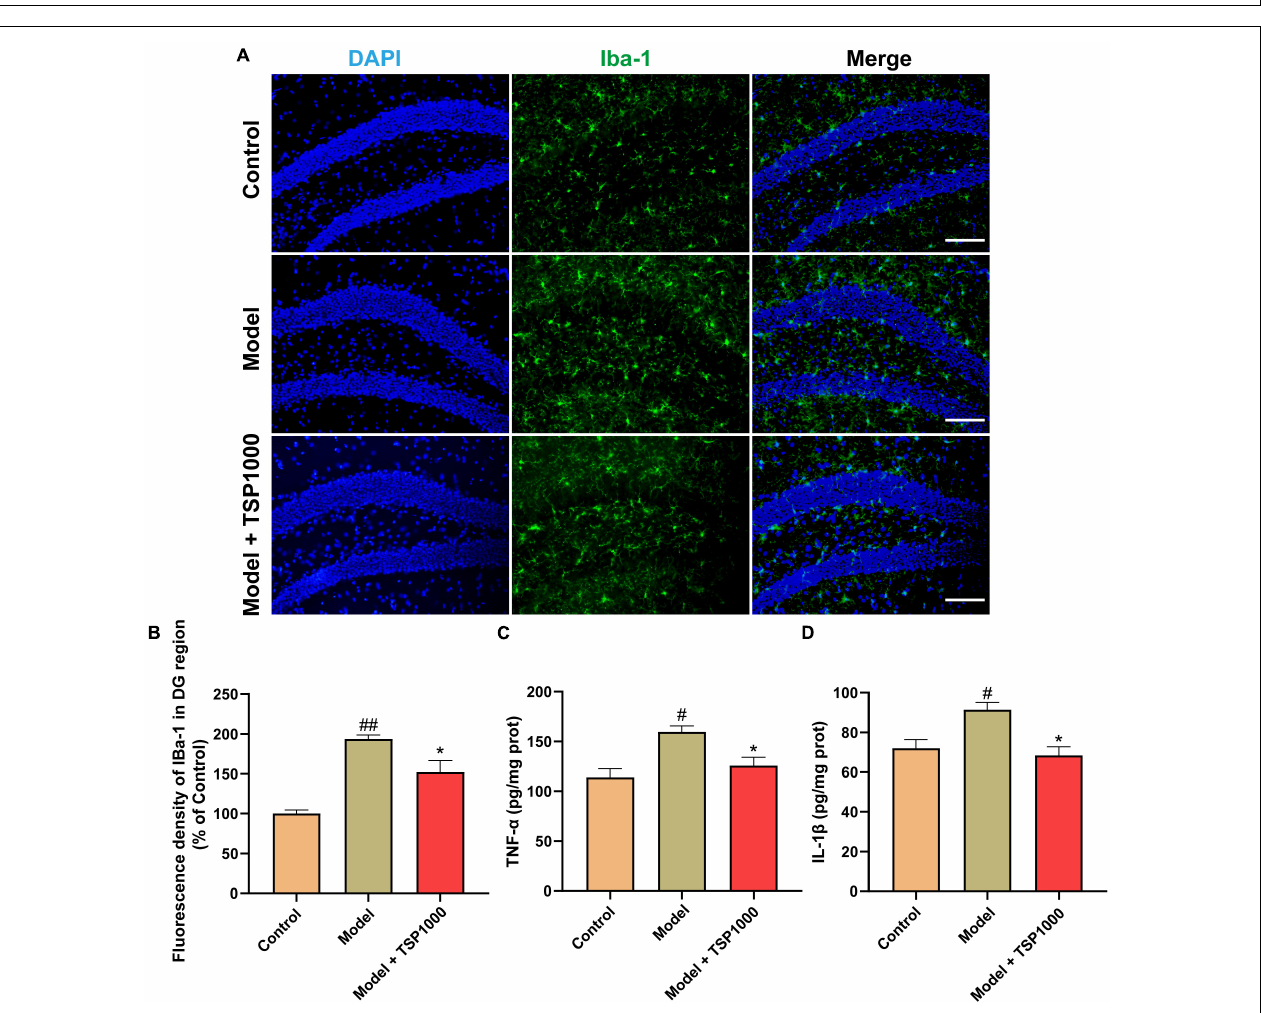
FIGURE 4 | The effects of TSP on hippocampal neuroinflammation. (A) The representative staining of activated microglia (Scale bar: 20 µ m). (B) The fluorescence density of Iba-1 in the DG region was calculated in the hippocampus. The levels of TNF- α (C) and IL-1 β (D) were tested in the hippocampus. All data were expressed as mean ± SEM ( n = 3). # P < 0.05, ## P < 0.01 vs. Control group; * P < 0.05 vs. Model group.